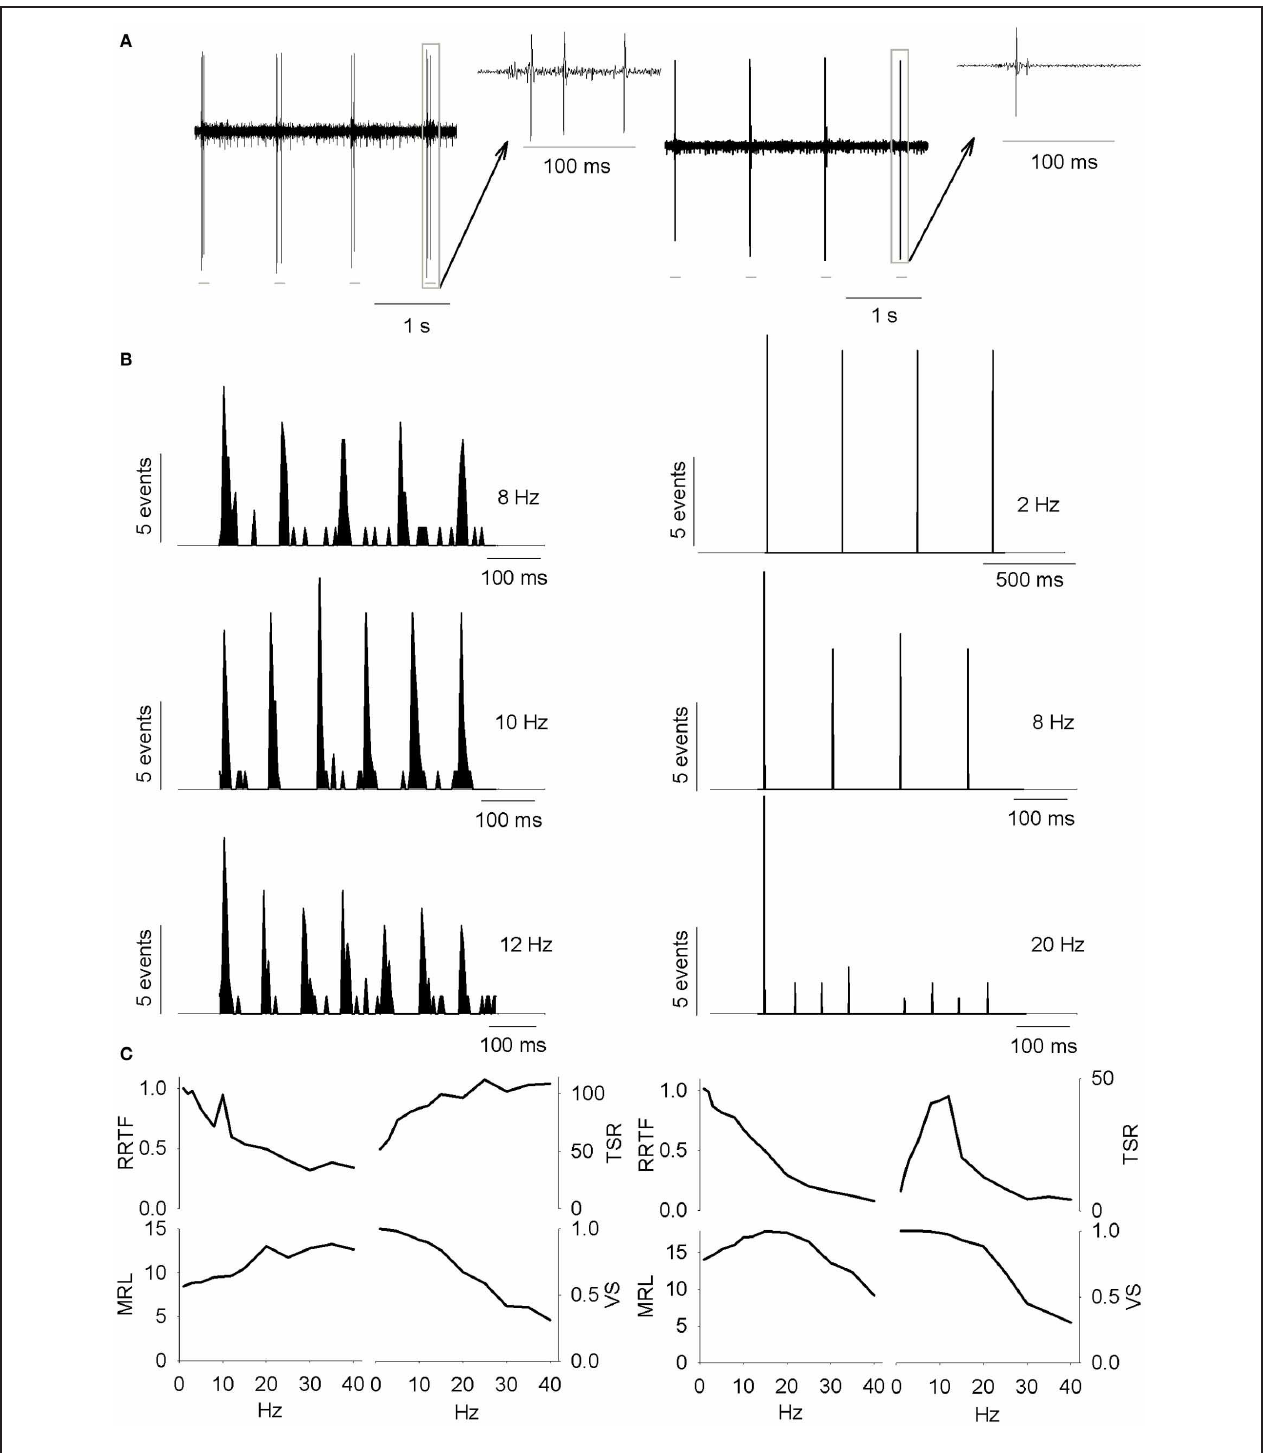
FIGURE 1 | (A) PrV tonic (T-left) and phasic (Ph-right) responses to four air-jet stimuli. Insets show the responses to an individual stimulus. Gray lines below the recordings indicate the duration of the stimuli. (B) Peristimuli histograms of the neural responses illustrated in (A) . Three different stimulation frequencies are shown. Tonic responses (left) display a clear potentiation at 10Hz while phasic ones reduce the number of spikes with the increase of the stimulation frequency. (C) Response rate transfer function, RRTF; total